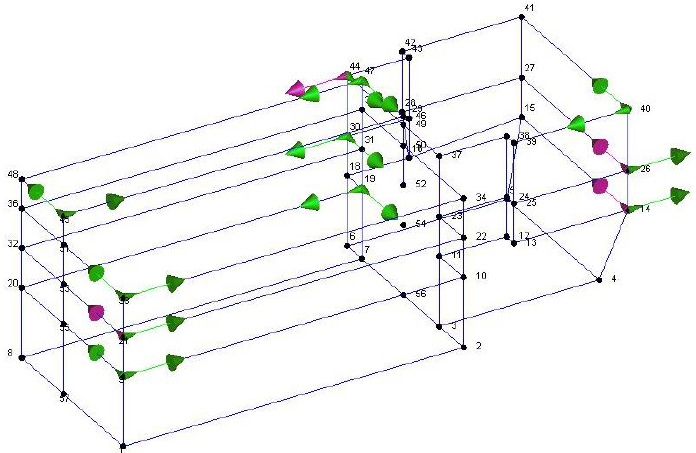
Figure 14. Geometry of Structure B for OMA along with accelerometers positions and directions. Sensors 2020 , 20 , x FOR PEER REVIEW